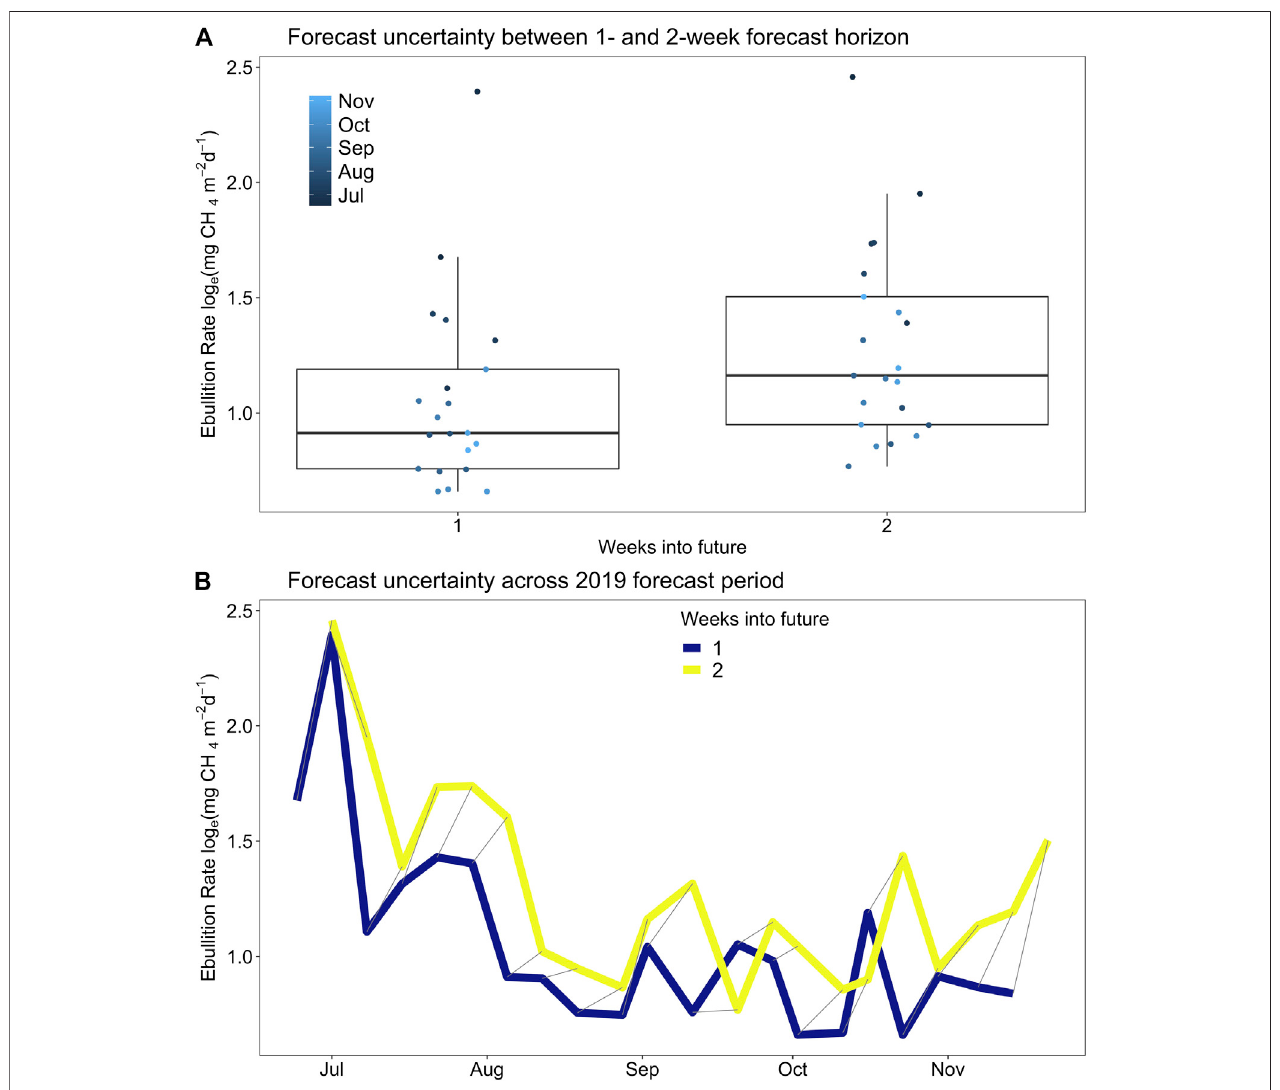
FIGURE 5 | The total forecast uncertainty (as measured by standard deviation of the forecast ensembles) for each week aggregated across forecast cycles for 1 and 2weeks intothe future Panel (A) . In panel (B) , each differentcolored linerepresentsthe number ofweeks intothe forecast horizon. The small grey lines are included as a guide to represent each forecast and how the uncertainty of each forecast mapped across the forecasting period.